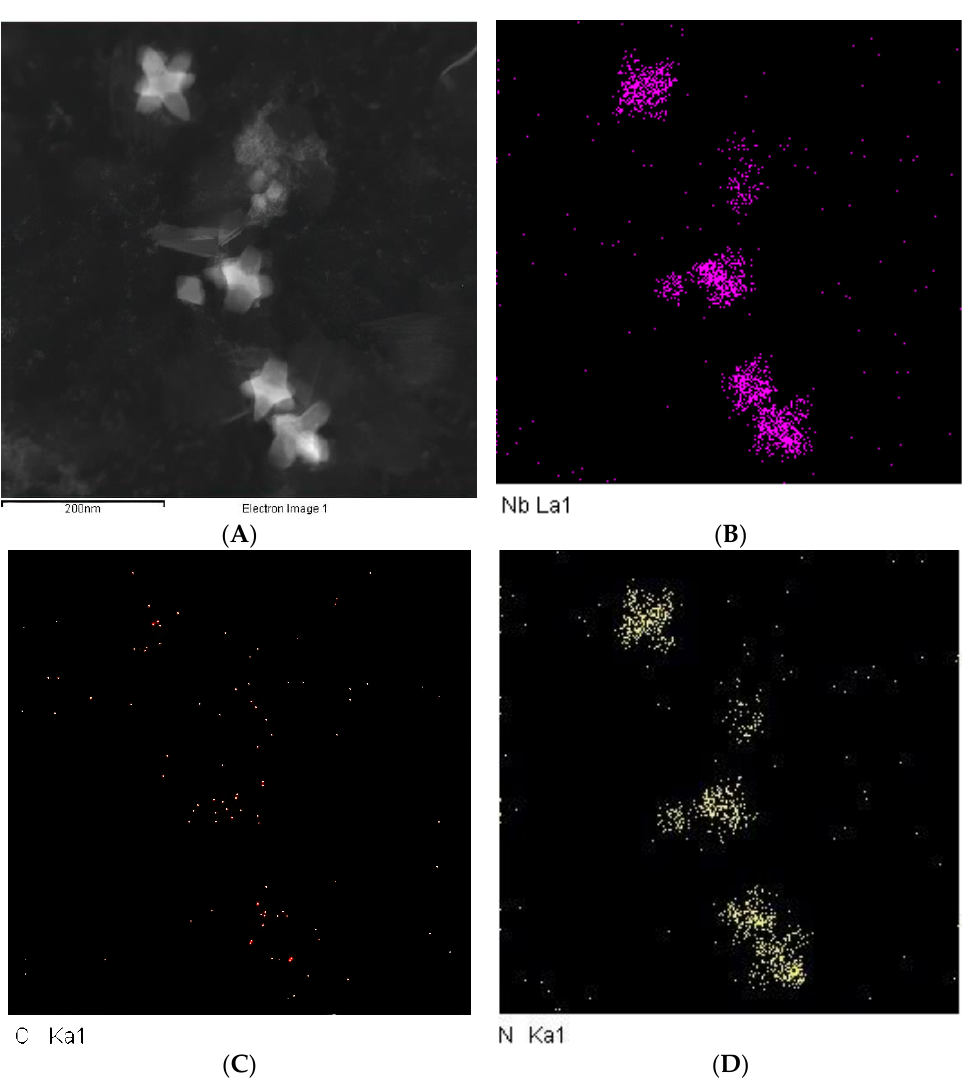
Figure 14. Analysis of the precipitated phase composition using transmission electron microscopy. ( A ) Typical Nb(C,N) morphology; ( B ) Distribution of Nb in the typical precipitates; ( C ) Distribution of C in the typical precipitates; ( D ) Distribution of N in the typical precipitates